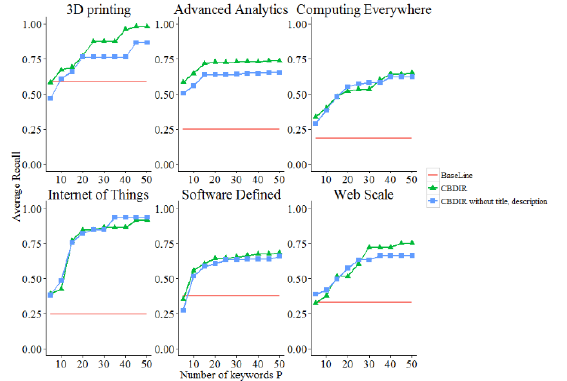
Fig. 6. Performance Evaluation - Average F-measure in each category across the number of keywords (red: baseline, green: CBDIR, blue line: CBDIR without the title and description information)